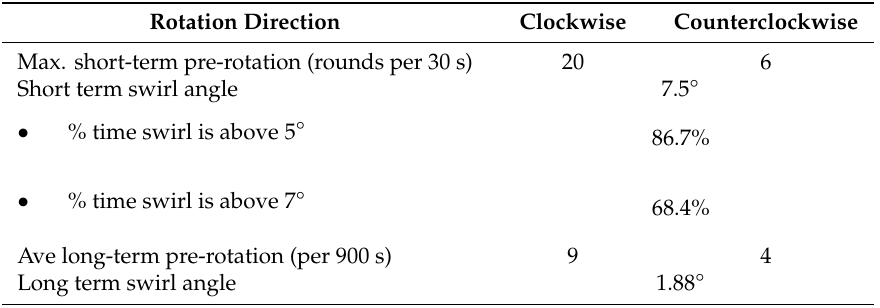
Table 3. Maximum short-term and average long-term swirl angles for the physical model test. Rotation Direction